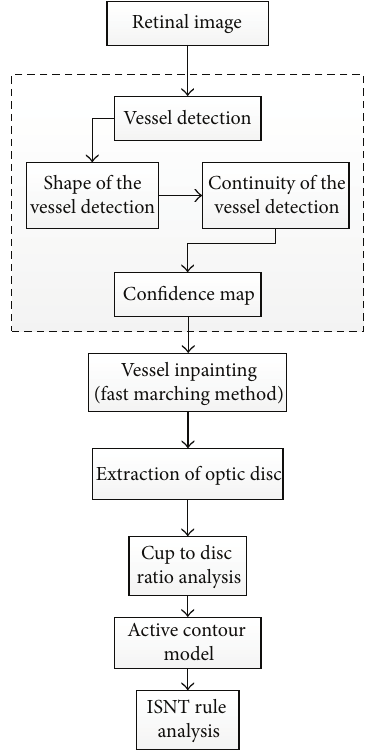
Figure 36: Flowchart for algorithm proposed in